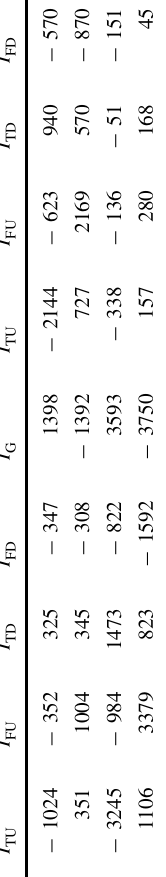
Table 3 Short-circuit currents of the 2nd and 4th tests in System A The 2nd test The 4th test Formula